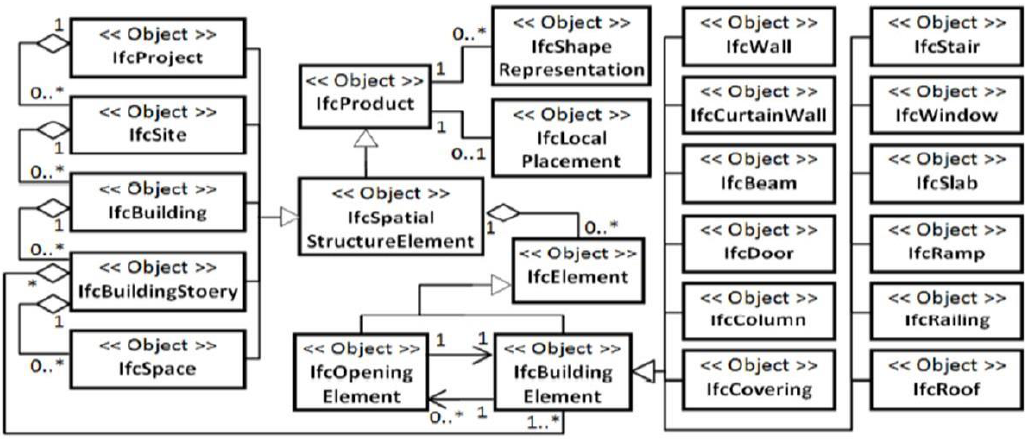
Figure 1. IFC building model (ISO 16739,